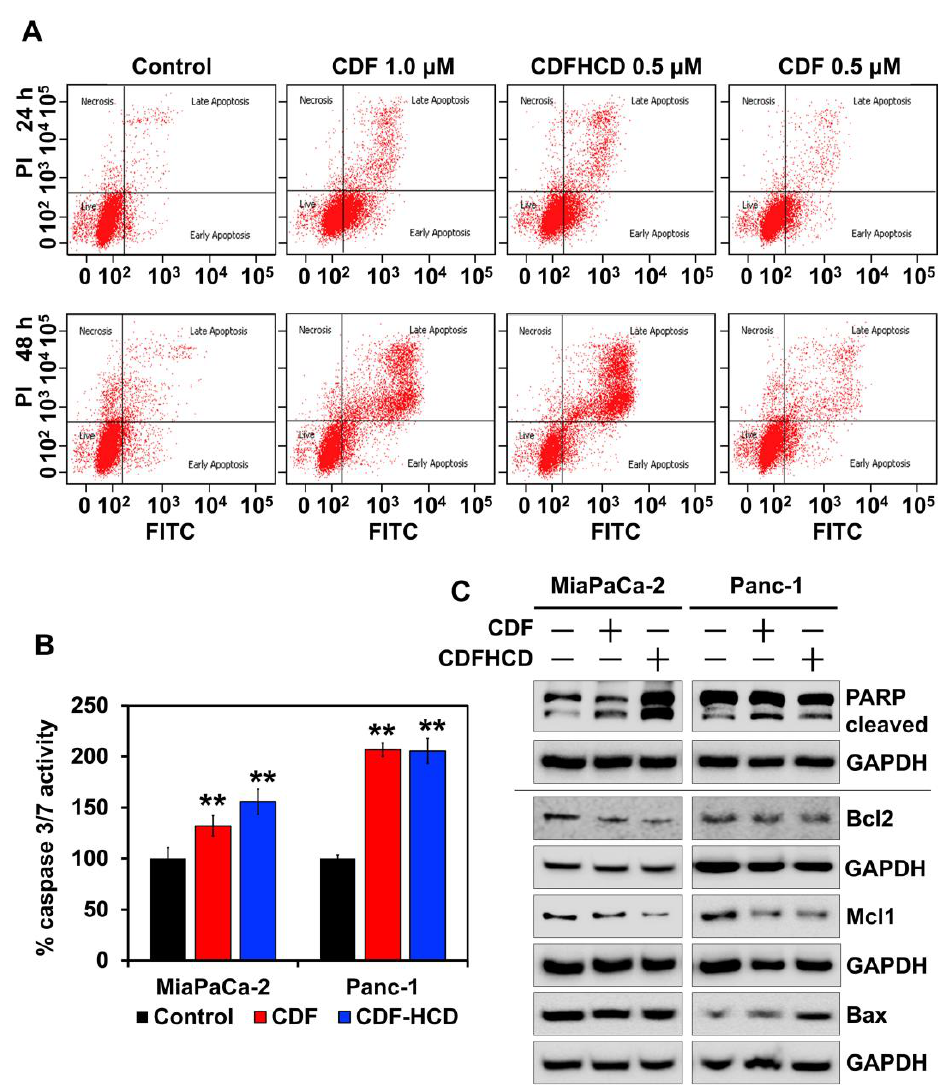
Figure 6. CDF and CDFHCD induce apoptosis. ( A ). Panc-1 cells were incubated with CDF and CDFHCD, stained with Annexin V-FITC and PI, and examined by flow cytometry. ( B ). Caspase 3/7 assay showed increased caspase activity in MiaPaCa-2 and Panc-1 cells at 48 h after treatment with CDF and CDFHCD (** p < 0.01). ( C ). PDAC cell lysates treated with CDF and CDFHCD were